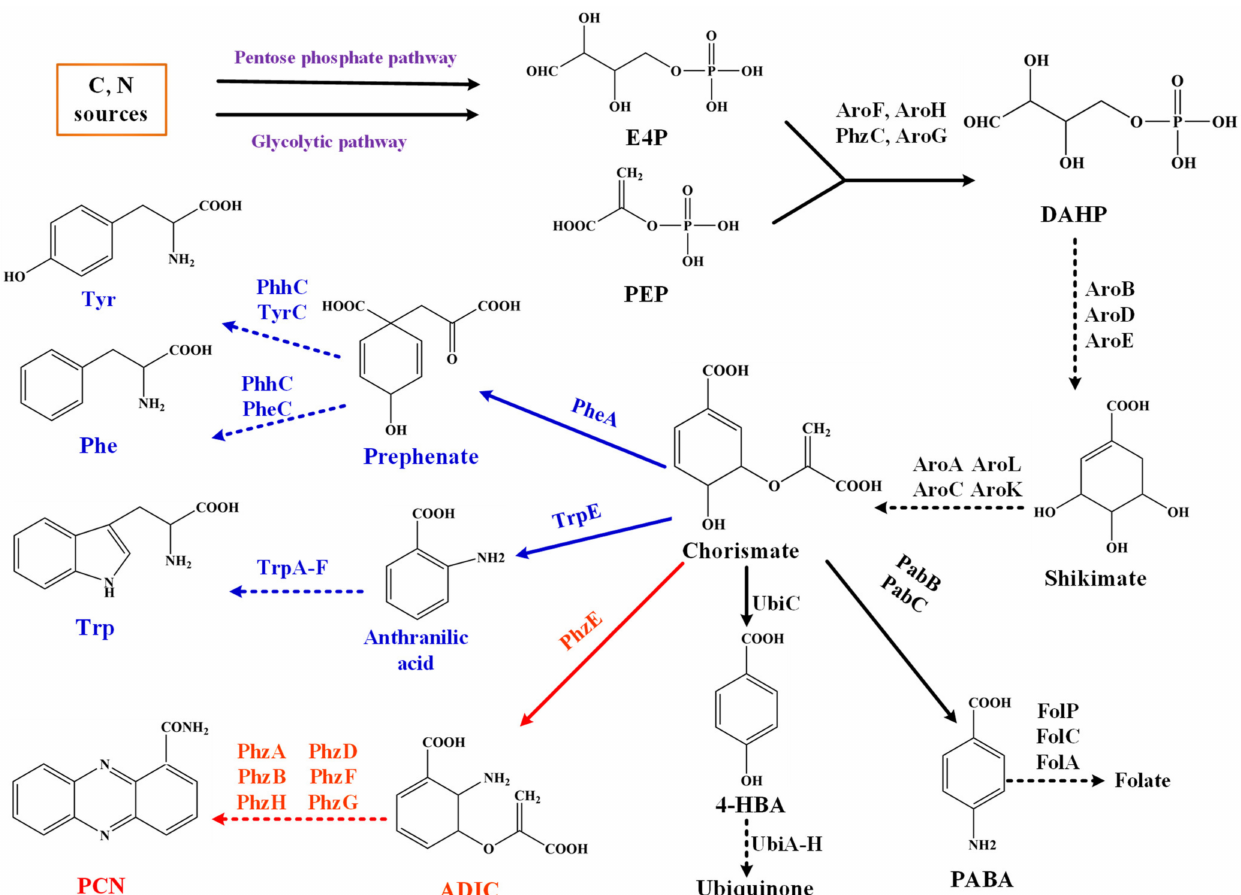
Figure 1. The shikimate pathway and chorismate-derived pathway in P . chlororaphis